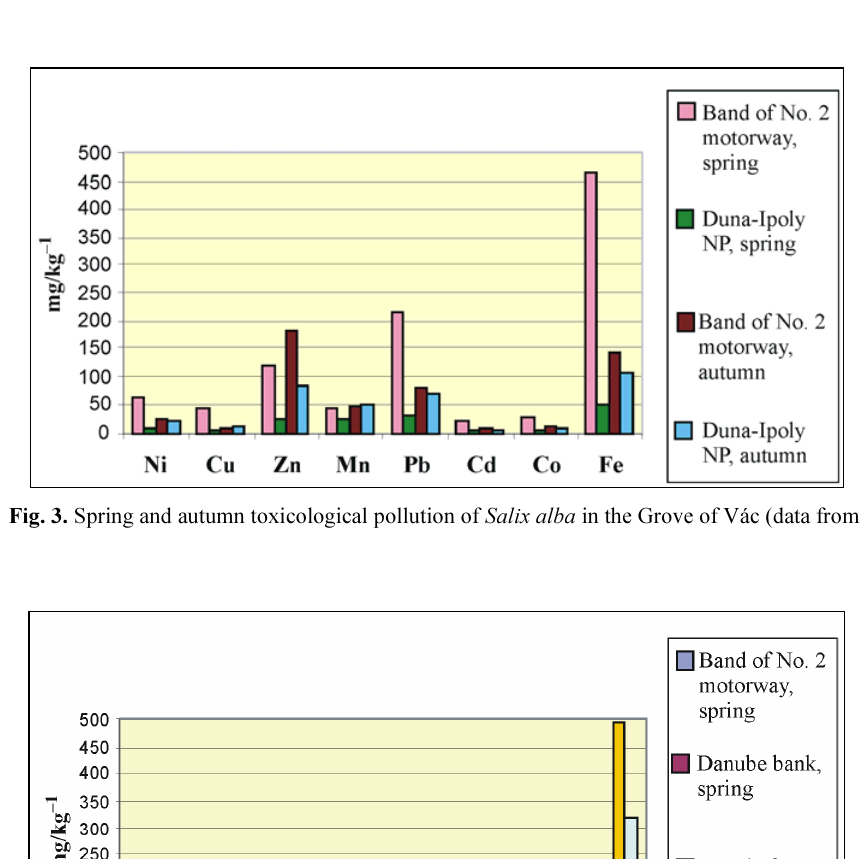
Fig. 2. Map of the study area in city of Vác